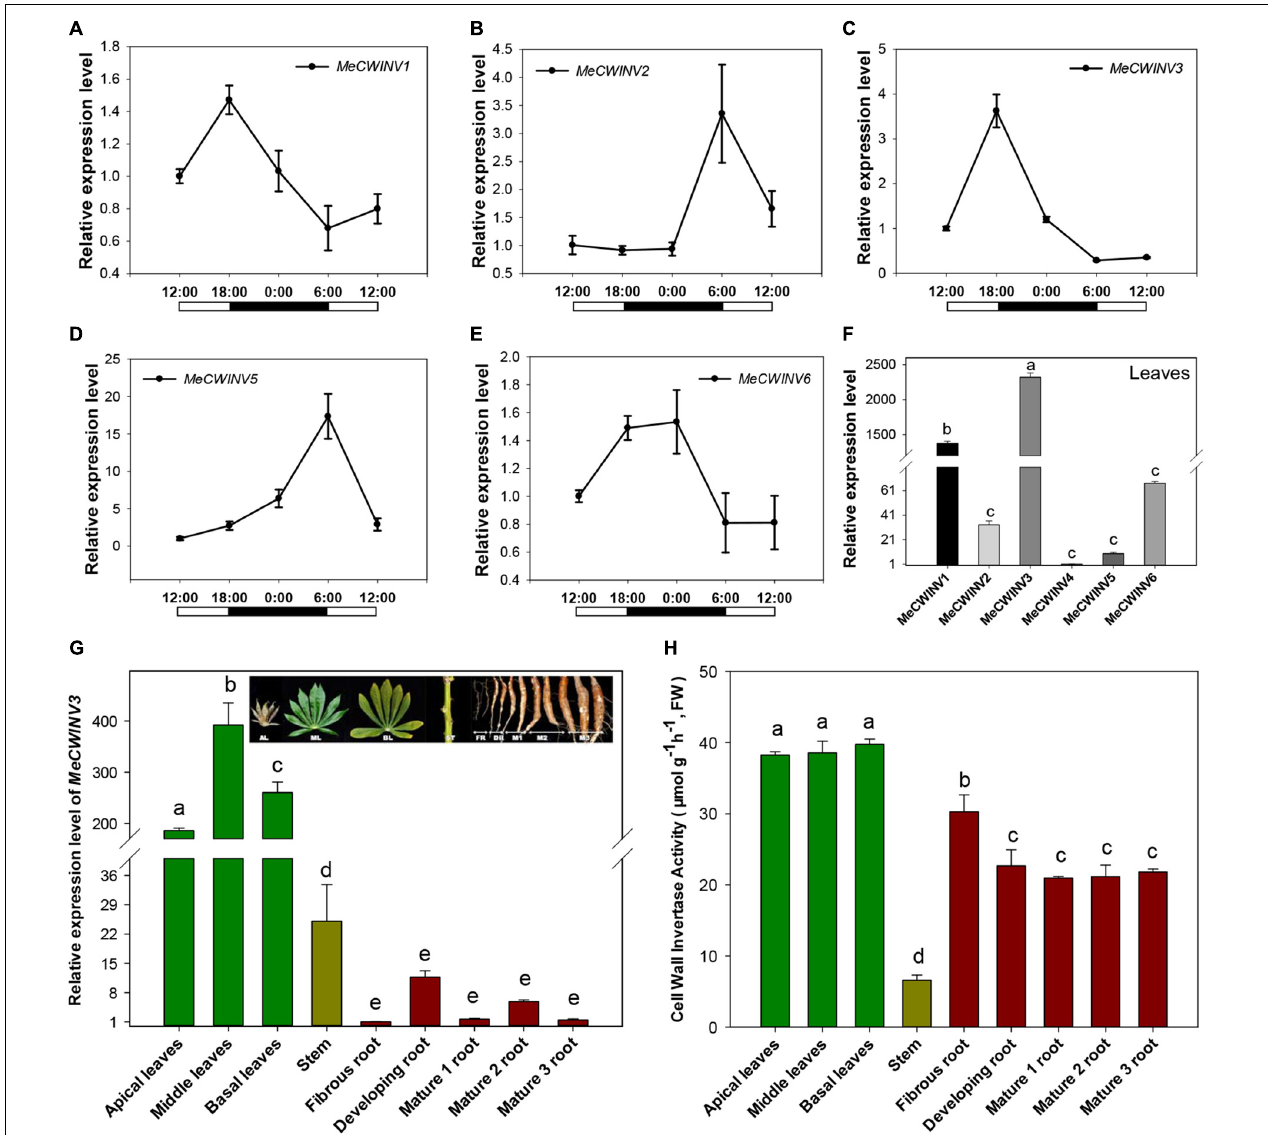
FIGURE 2 | Expression patterns of CWINVs in cassava. (A–E) Relative expression levels of five CWINV genes in cassava leaves under a day/night cycle. (F) Relative transcript levels of six cassava CWINV genes in cassava leaves collected from pot-grown plants at 10:00 a.m. (G,H) Relative expression levels of MeCWINV3 (G) and CWINV activities (H) in different types of cassava organs including leaves, stem, and roots. Data represent means ± SD of three independent assays. Different letters indicate significant differences (one-way ANOVA, p <